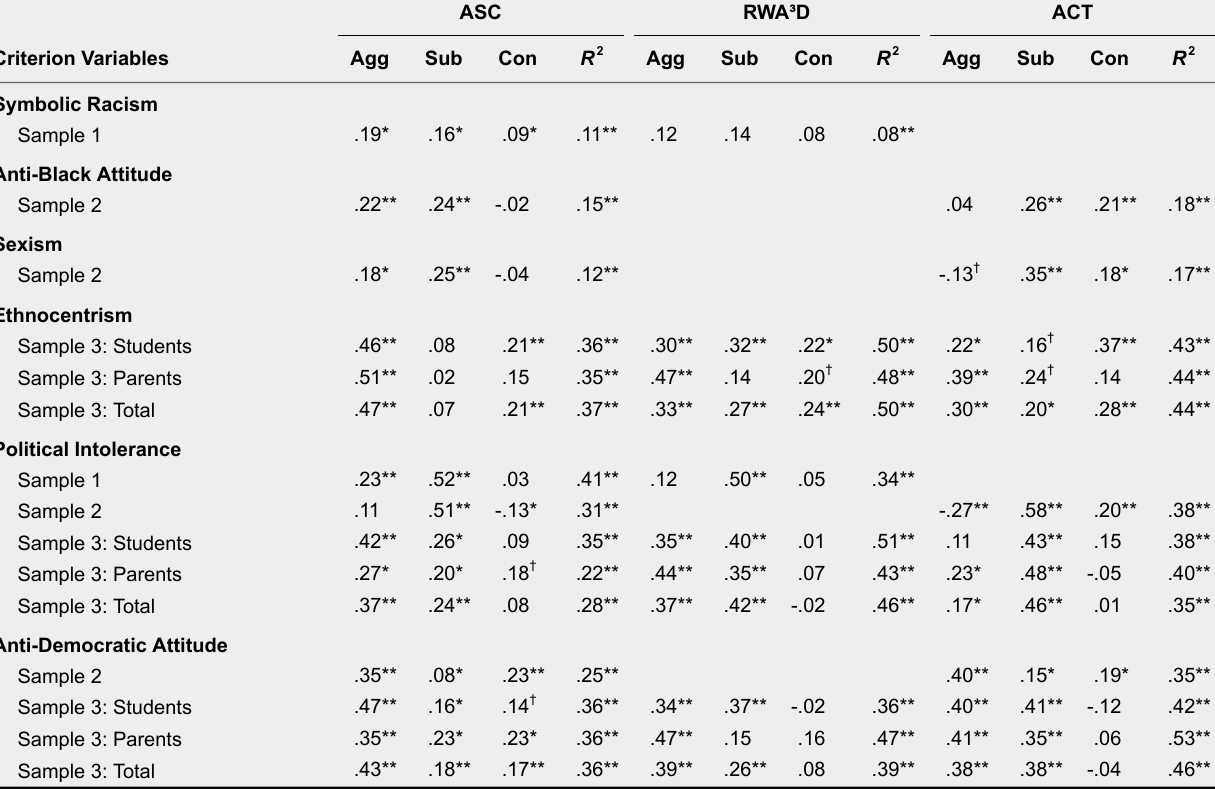
Beta Coefficients and R 2 for Traditional Target Variables of